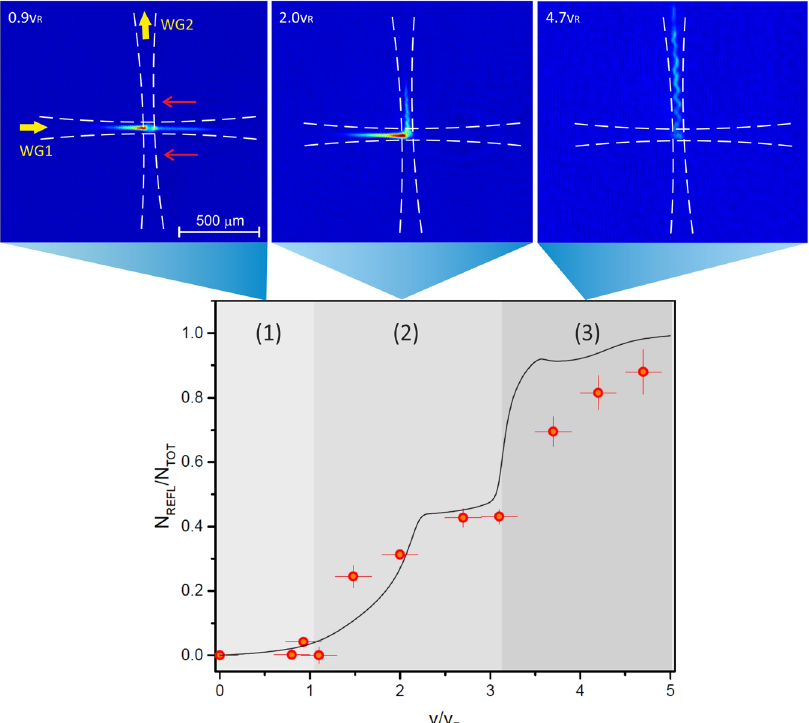
Figure 3. The maximum fraction of atoms reflected into WG2 obtained by optimizing ε , here plotted as a function of the initial velocity of the BEC. Three regimes of propagation are observed experimentally: (1) for low velocity v ≲ v R the atoms stop at the edge of the crossing region and only a few atoms enter WG2 propagating in both its two directions (this weak signal in WG2 is highlighted by the red arrows), (2) for higher velocities v R < v ≲ 3v R the atoms start to be reflected into a single port of WG2, (3) when v > 3v R the atoms are almost fully reflected into WG2. The atomic clouds are imaged after passing through the intersection region, for different lattice amplitudes, with 2 ms time-of-flight. White dashed lines are added to the images of the atoms to show the orientation of the two waveguides. The black solid line in the graph refers to the numerical solution of the time-dependent Schroedinger equation in 2D, which shows a good agreement with the experimental